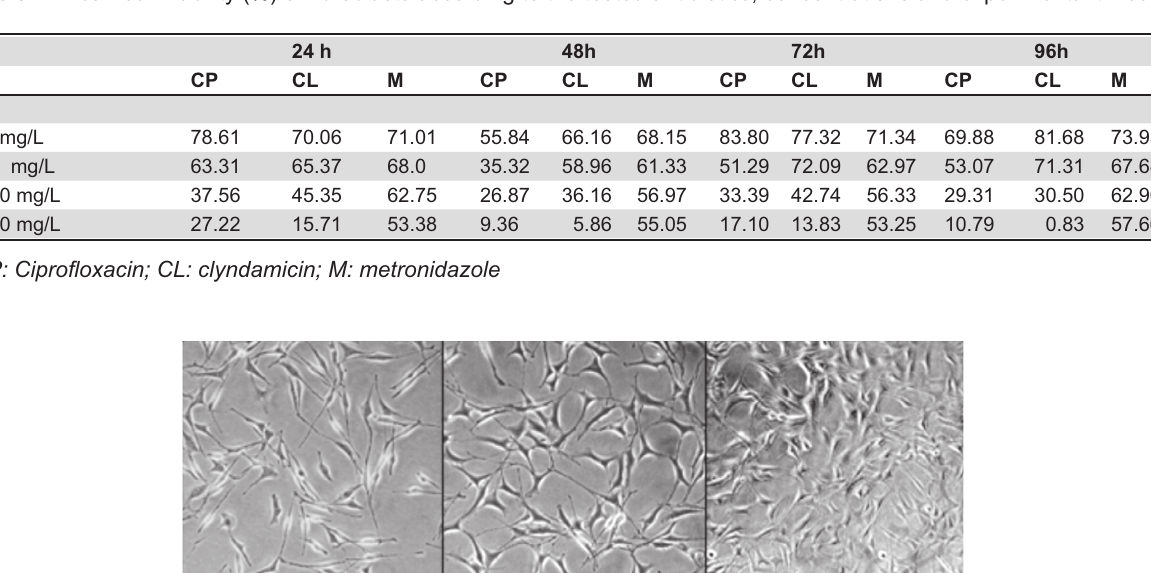
Table 1- !6+# 56** B$+)$*$%C 0D2 "> ()&")*+,%, +55"&3$#' %" %.6 %6,%63 +#%$)$"%$5,E 5"#56#%&+%$"#, +#3 6A=6&$<6#%+* %$<6,